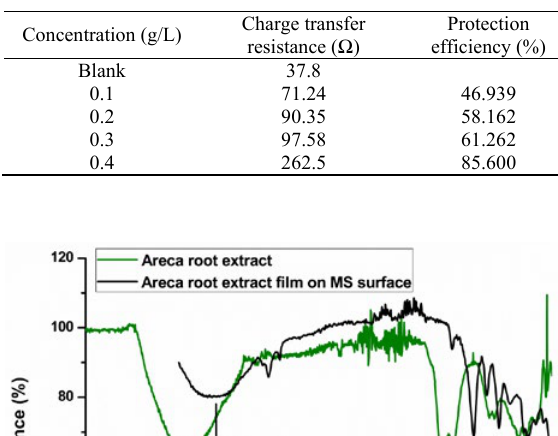
Fig. 7. Equivalent circuit of model R (QR (QR)) Table 5. Nyquist plot results